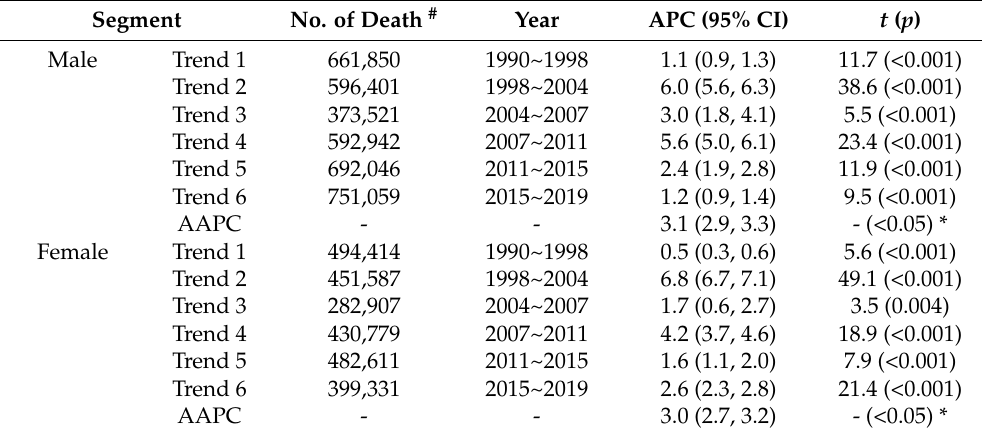
Table 1. Annual percent change for crude mortality attributable to low whole-grain intake by gender in China,